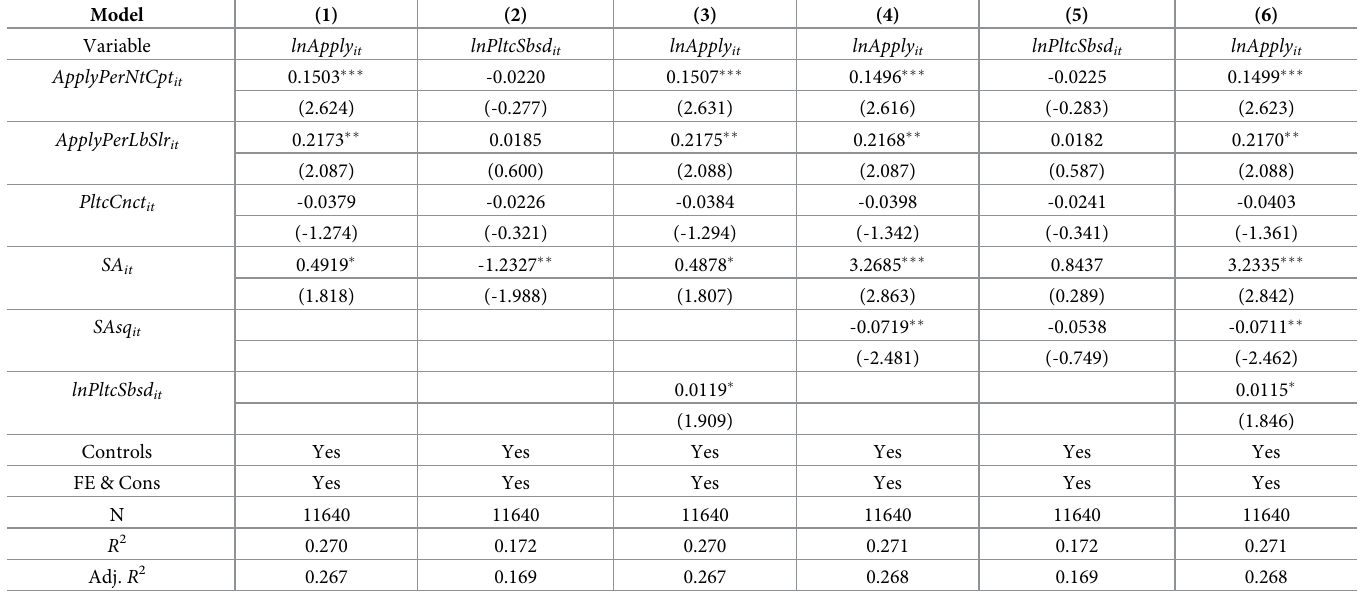
Table 3. Main results of baseline